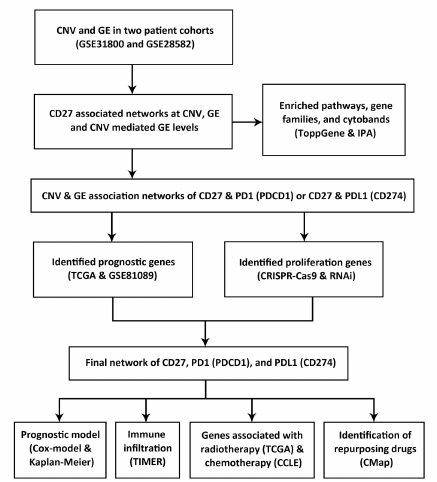
Figure 1. Overall study scheme. The arrows indicate analysis